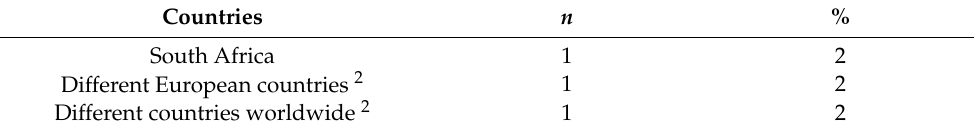
Table 2. Cont. Countries n % South Africa 1 2 Different European countries 2 1 2 Different countries worldwide 2 1